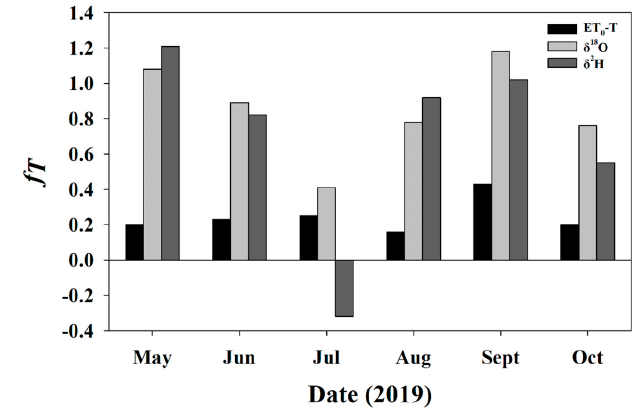
Figure 7. The fractional contribution of transpiration to total evapotranspiration on sampling events during the 2019 growing season calculated using the stable isotope method for both δ 2 H (dark grey bars) and δ 18 O (light grey bars), and using the residual of T/ET 0 from scaled sap flow measurements (black bars).